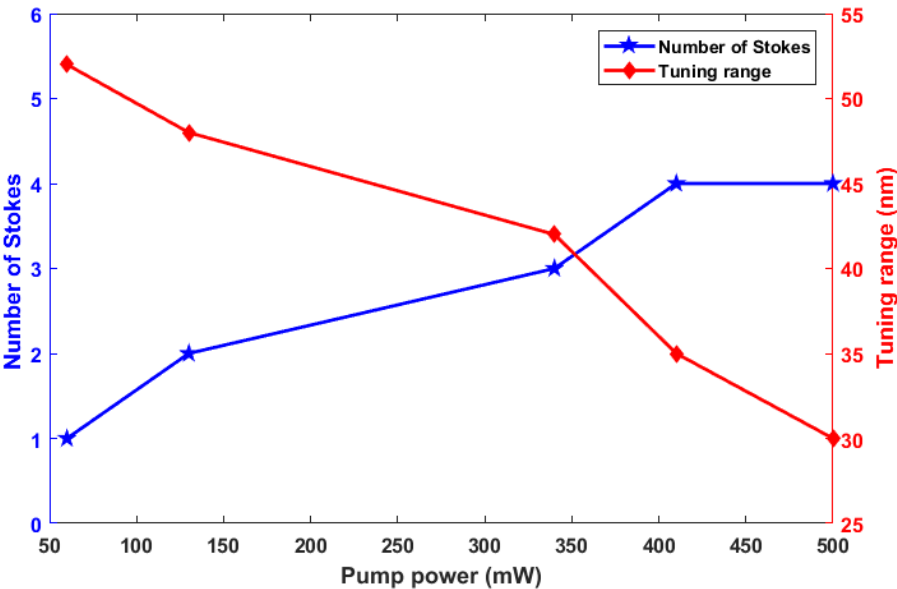
Figure 6. Pump power effect on generated Stokes signals and tuning